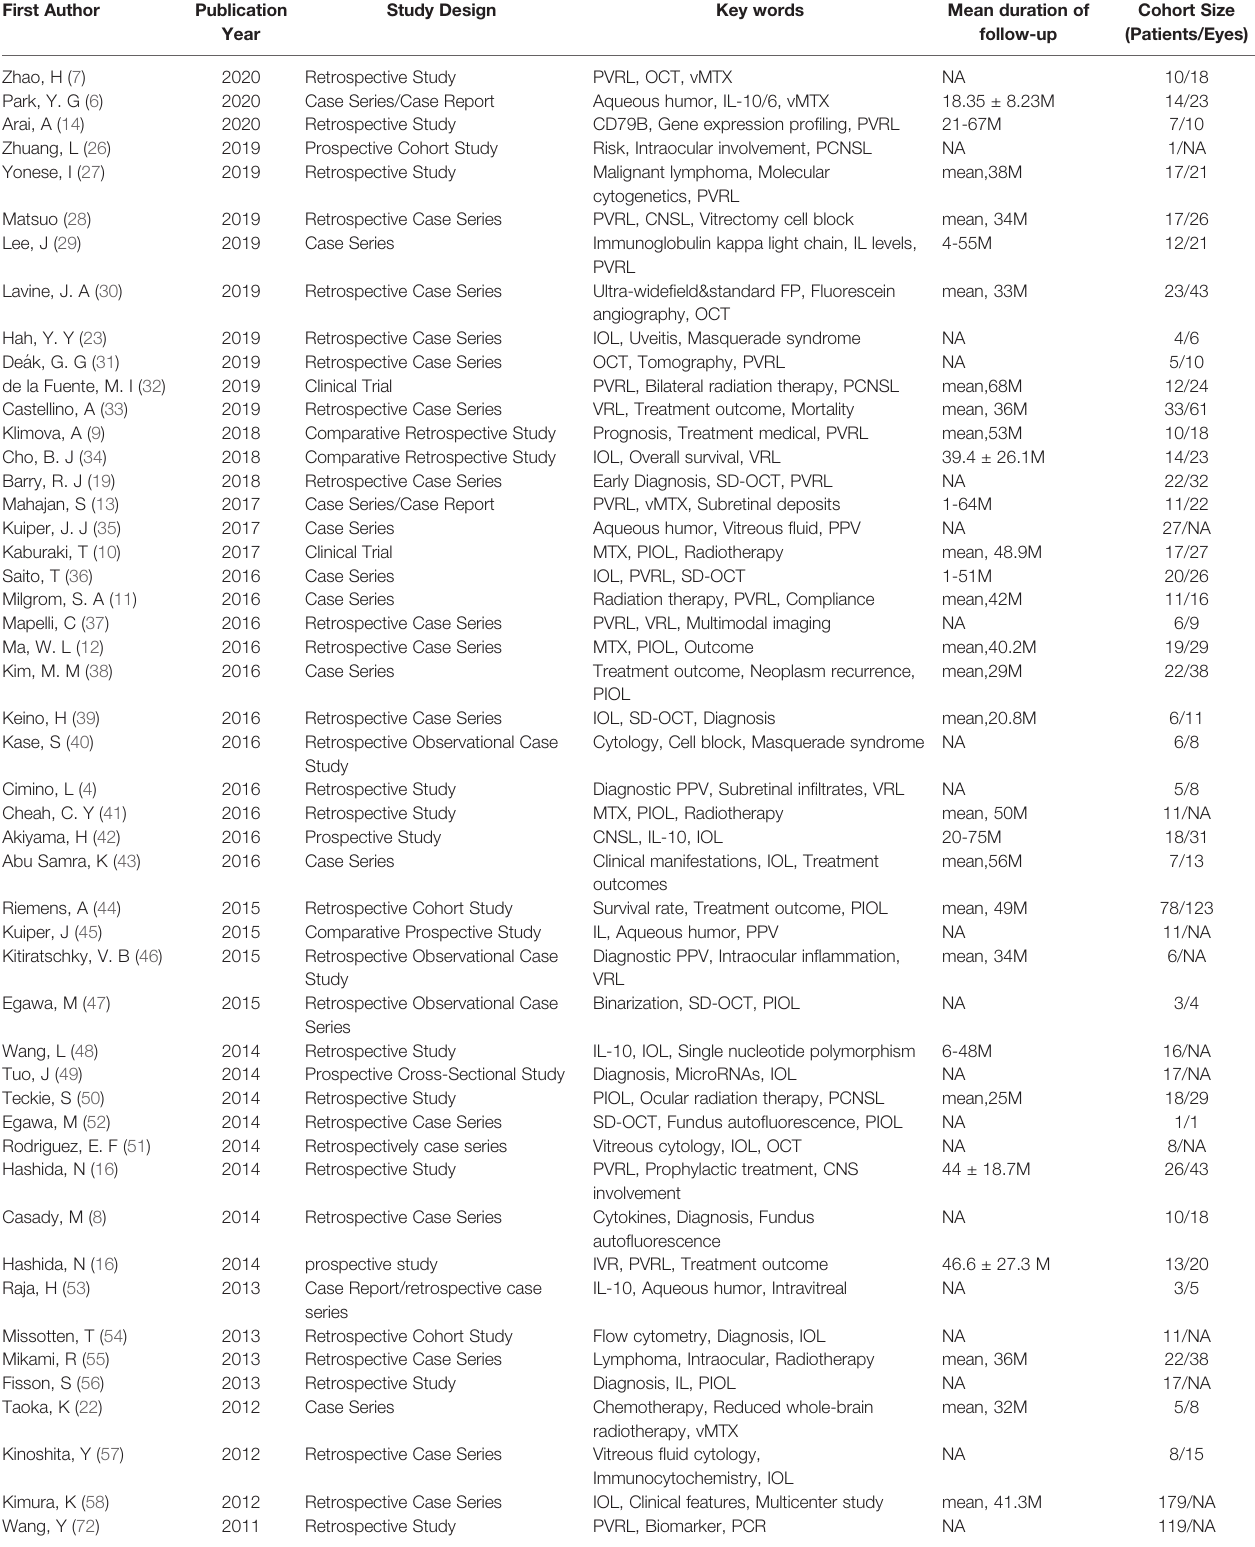
TABLE 1 | Main characteristics of the included